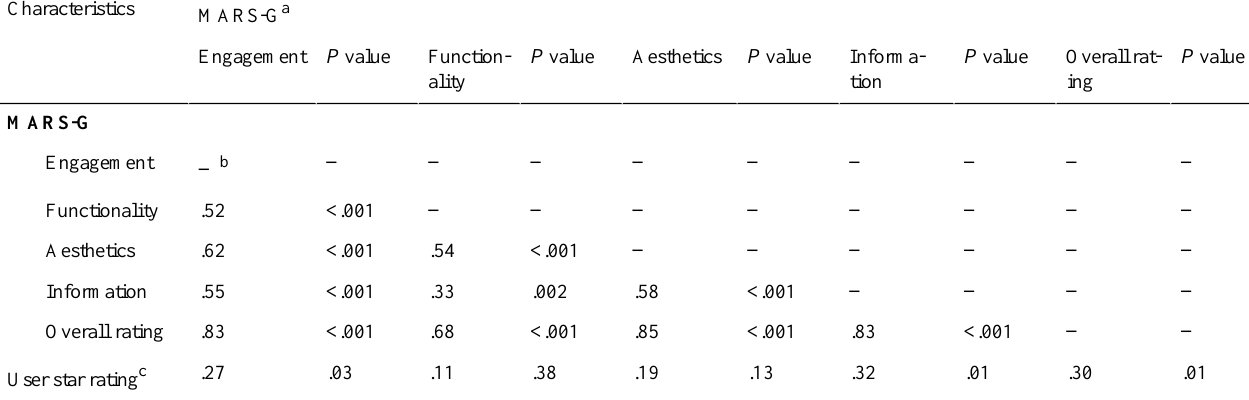
Table 3. Correlations between the mean values of the four MARS-G subdimensions, overall rating and user star